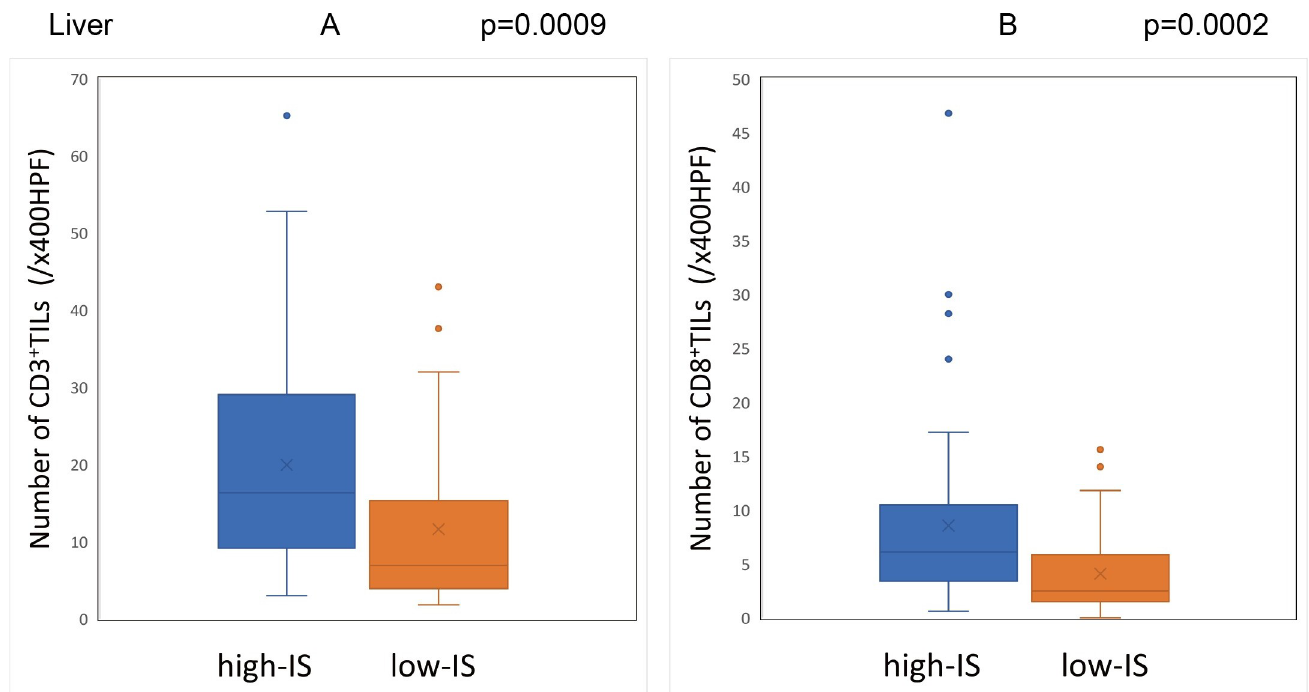
Fig 10. Relationship between the Immunoscore of primary tumors and the degree of TIL infiltration in the liver metastases. (A) (B) The density of tumor- infiltrating lymphocytes in liver metastases with high-Immunoscore primary tumors was significantly higher than that with low-Immunoscore primary tumors (CD3: p = 0.0009, CD8: p = 0.0002).